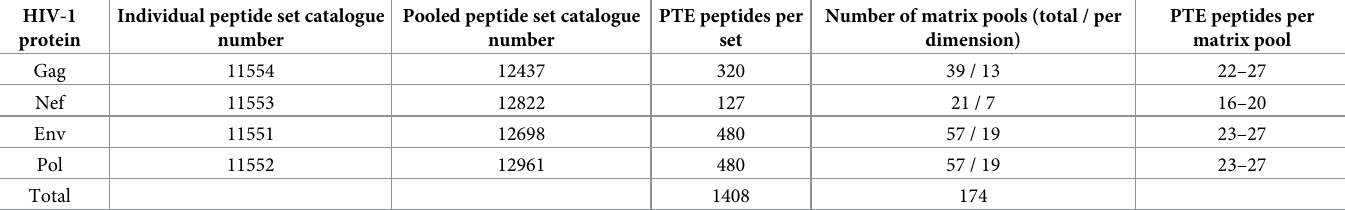
Table 2. PTE peptide sets and peptide pool details. Sets of individual 15mer peptides and pools of peptides for HIV-1 Gag, Nef, Env and Pol proteins were supplied by the NIH HIV Reagent program, USA. HIV-1